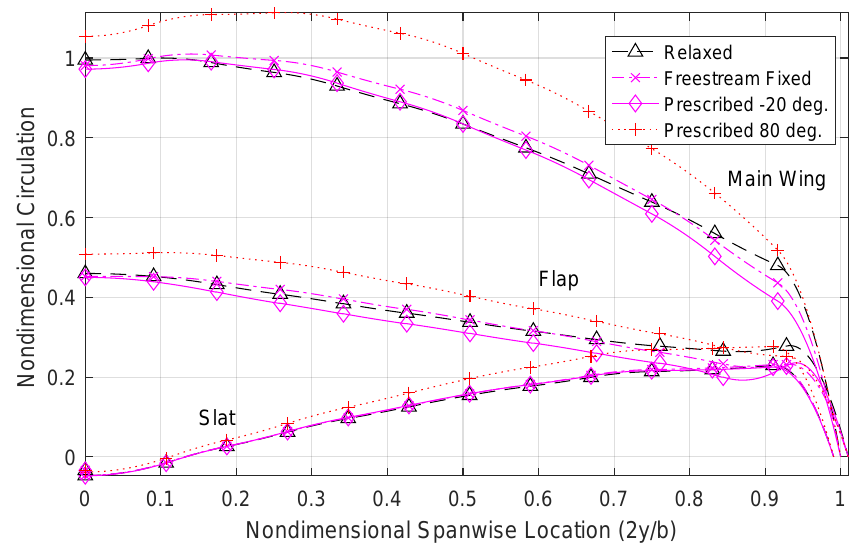
Figure 16. Predicted spanwise circulation distributions for the NASA Trap Wing LaRC Configuration 1, at an angle of attack of 20 degrees. Values are normalized to the circulation at the main wing root section, as predicted with a relaxed